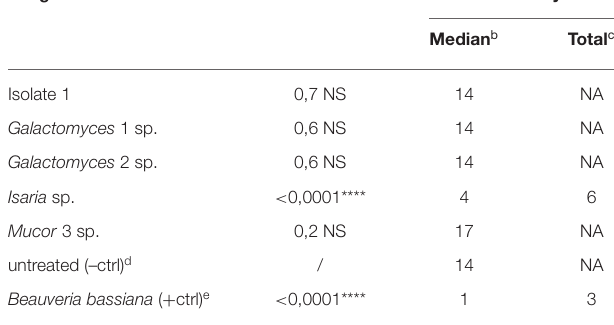
to allow the spores to come in contact with the mosquito surface. As a negative control, mosquitoes were dipped in a non-spore-containing solution. The spore-dipping experiments were performed in triplicate, and the two mosquito species were tested with the respective fungi that had shown a significant ( p < 0.0001) killing activity in the direct-exposure assay. Five-days-old An. gambiae females were tested against isolate 1, G. candidum 1 and 2 , I. fumosorosea, and M. hiemalis . All five fungi displayed a strong and significant ( p < 0.0001) mosquitocidal activity after dipping of the mosquitoes into the spore solution ( Table 3 , Figure 2A ). The median lifespan of the negative control cohort was 8 days, and the mosquitoes exposed to isolate 1, G. candidum 2, or I. fumosorosea displayed a 2-day median survival time. Mosquitoes exposed to spores of G. candidum 1 or M. hiemalis showed a median survival time of 4 and 3 days,